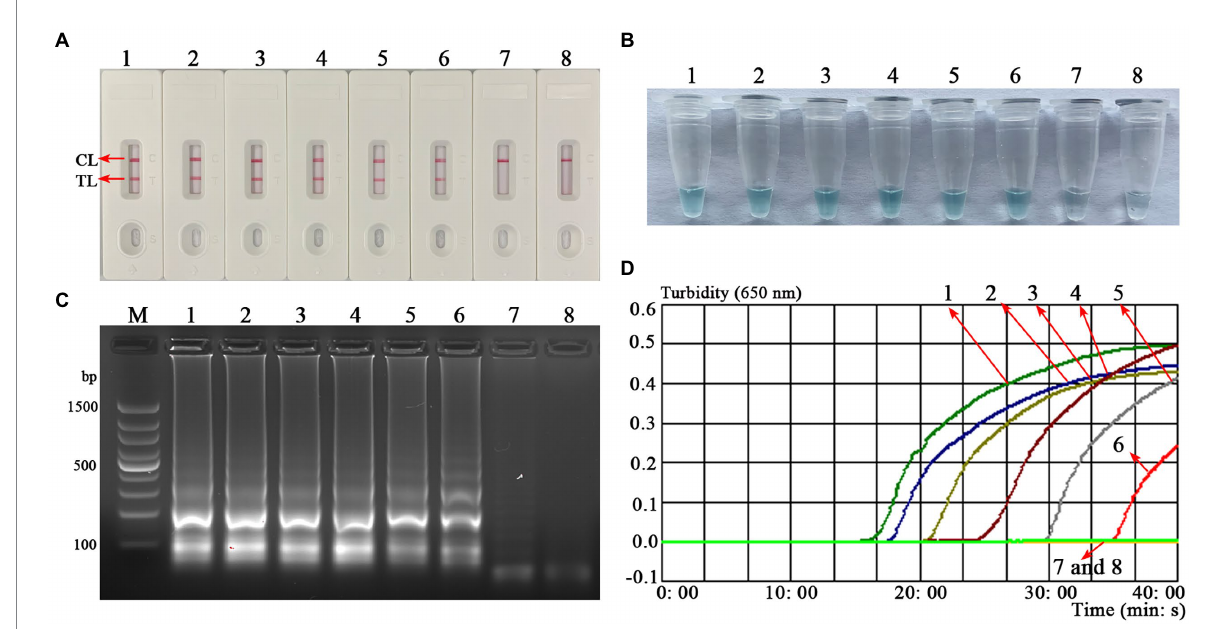
FIGURE 6 Analytical sensitivity of the B. abortus -MCDA-LFB assay. One microliter of each diluent of genomic DNA from the B. abortus strain (1 ng/ μ l, 100 pg/ μ l, 10 pg/ μ l, 1 pg/ μ l, 100 fg/ μ l, 10 fg/ μ l, and 1 fg/ μ l) was used as an amplification template to evaluate the analytical sensitivity of the B. abortus - MCDA-LFB assay. The AuNPs-LFB biosensor ( A ), MG amplification indicators ( B ), 1.5% agarose gel electrophoresis ( C ), and real-time turbidity ( D ) were used to validate the amplification products of the B. abortus -MCDA assay. Strip ( A1–A7 )/tube ( B1–B7 )/lane ( C1–C7 )/curve ( D1–D7 ) correspond to 1 ng/ μ l, 100 pg/ μ l, 10 pg/ μ l, 1 pg/ μ l, 100 fg/ μ l, 10 fg/ μ l, and 1 fg/ μ l. Strip ( A8 )/tube ( B8 )/lane ( C8 )/curve ( D8 ) correspond to blank control (nuclease-free water). Line M , 100 bp DNA ladder; MCDA, multiple cross displacement amplification; AuNPs-LFB, gold nanoparticles-based lateral flow biosensor; TL, test line; CL, control